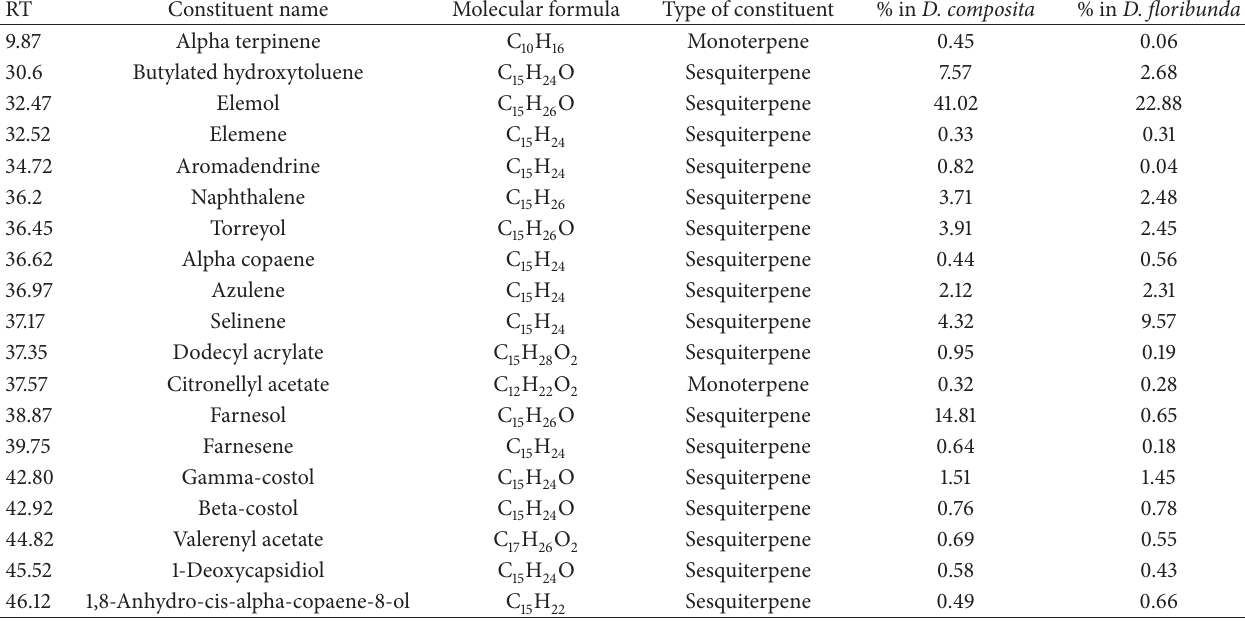
Table 2: Essential oil constituents and their percentages in oil from Dioscorea composita and Dioscorea floribunda .